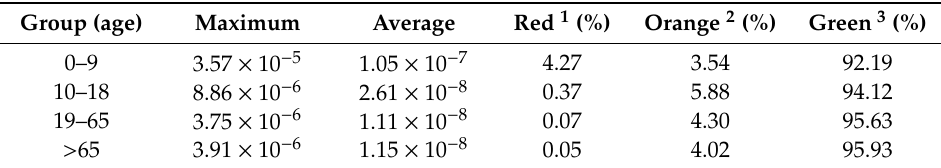
Table 4. Exposure